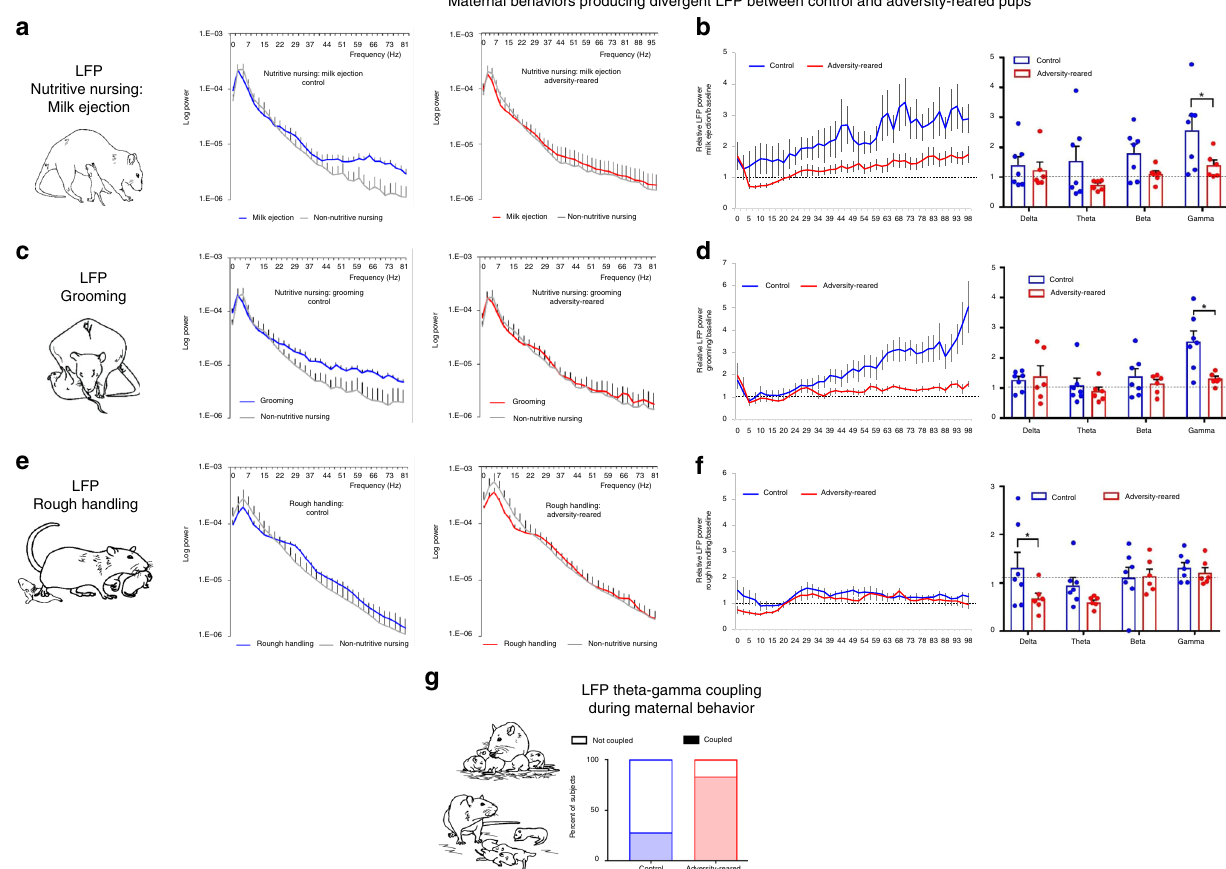
Fig. 5 During adversity-rearing, pup LFP response to speci fi c maternal behaviors is decreased. a While milk ejection increased pups ’ oscillatory power in the theta and gamma ranges, these inputs failed to modulate oscillations in the same pups during maltreatment. Left, log LFP power; b LFP power normalized to LFP during nonnutritive nursing (between milk ejections, “ baseline ” ). c Grooming failed to modulate pup cortical oscillations when this occurred within adversity-rearing. Data normalized to baseline are shown in ( d ) and ( e ). Speci fi c oscillatory responses to maternal behavior during actual rough handling (i.e., during stepping on pup or dragging pups) differed minimally between the control and adversity-reared conditions, limited to the delta range, shown normalized in ( f ). g Cortical theta-gamma coupling was more reliably observed during bouts of adversity-rearing. * p < 0.05, ANOVA. Error bars = SEM. Dashed line = no change from baseline (non-nutritive nursing LFP power). Source data are provided as a Source Data fi